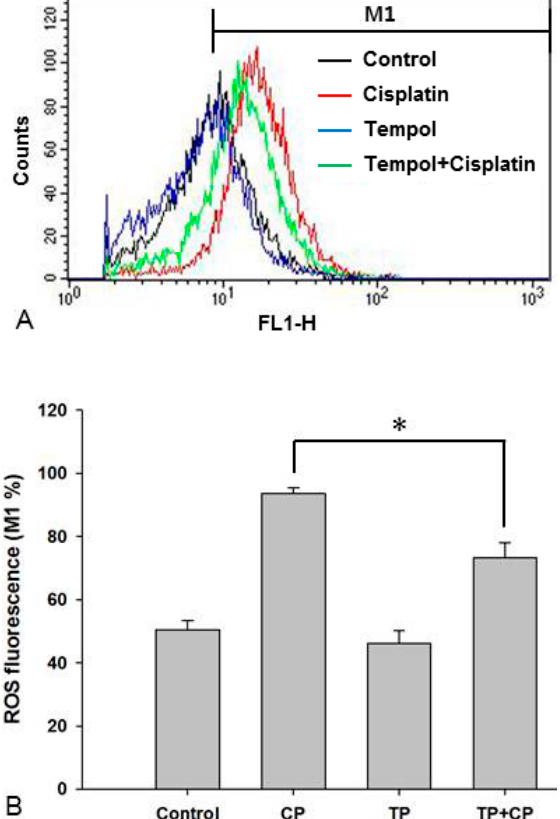
Figure 4. Intracellular reactive oxygen species (ROS) levels were determined by flow cytometry and representative histograms of ROS fluorescence are illustrated in ( A ). ROS production increased in the cisplatin-alone group. However, this increase in ROS levels was significantly inhibited in the cisplatin exposure after Tempol-pretreatment group ( B , * p < 0.05, paired Student’s t -test). Each group was tested in triplicate. CP, cisplatin; FL1-H, fluorescence channel 1 height; M1, marker 1; TP, Tempol.